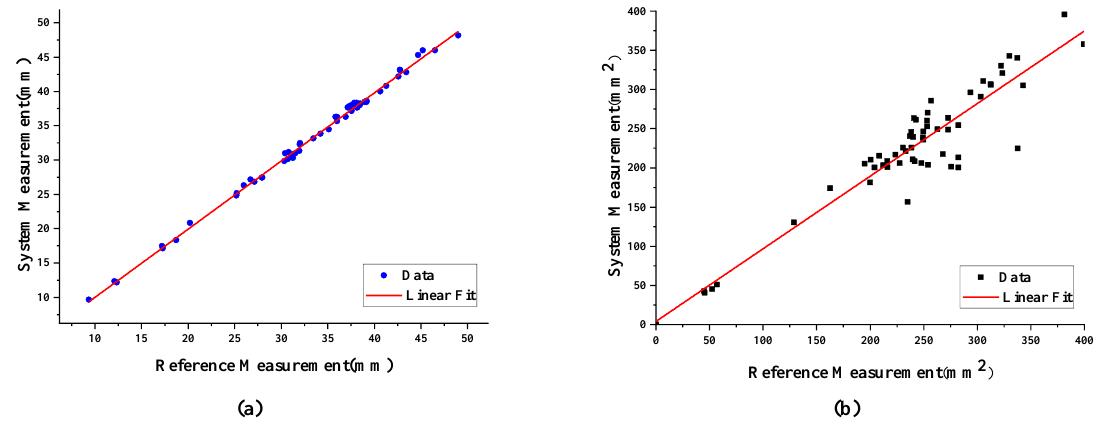
Figure 13. Data distribution and fitting results for cucumber seedling height ( a ) and projected leaf area ( b ).